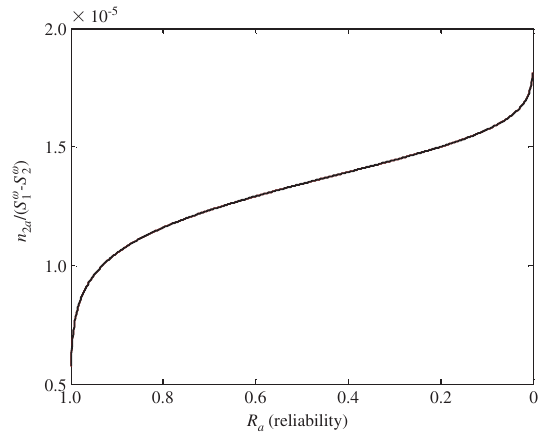
( ) ω ω - vs. R a 2 1 2